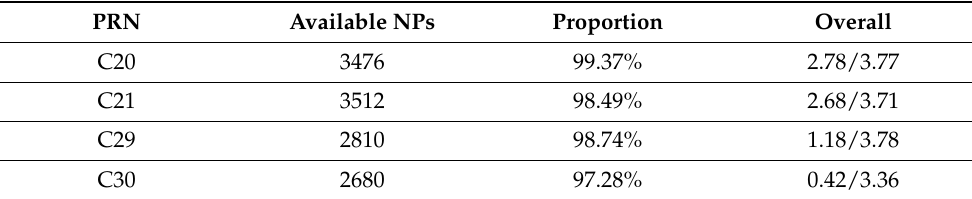
Table 4. The number of available SLR NPs, the proportion of the available SLR NPs, and the mean/RMS for SLR validation residuals (unit: